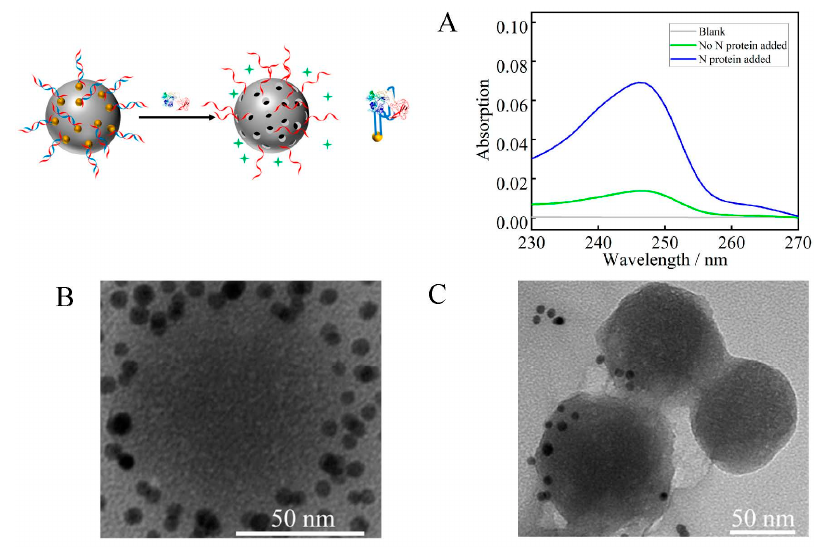
Figure 3. UV-vis absorption diagram of RDV concentration ( A ). TEM image of MSN-Au ( B ), and TEM image of MSN-Au after incubation with N protein ( C ).